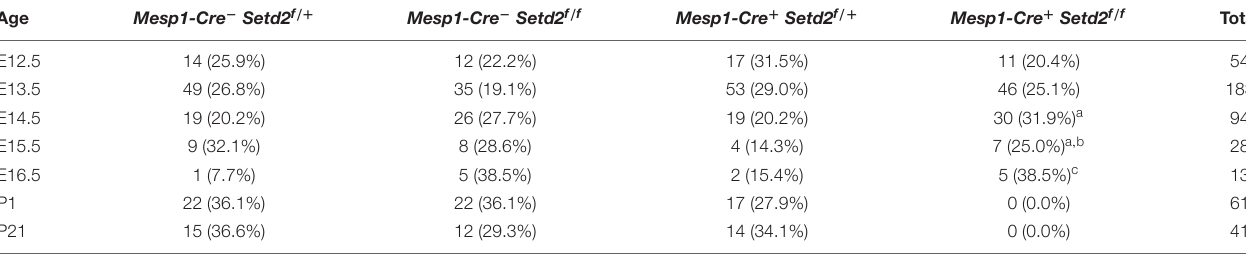
TABLE 1 | Genotypic analysis of the offspring from Mesp1-Cre + Setd2 f / + × Setd2 f / f intercrosses.